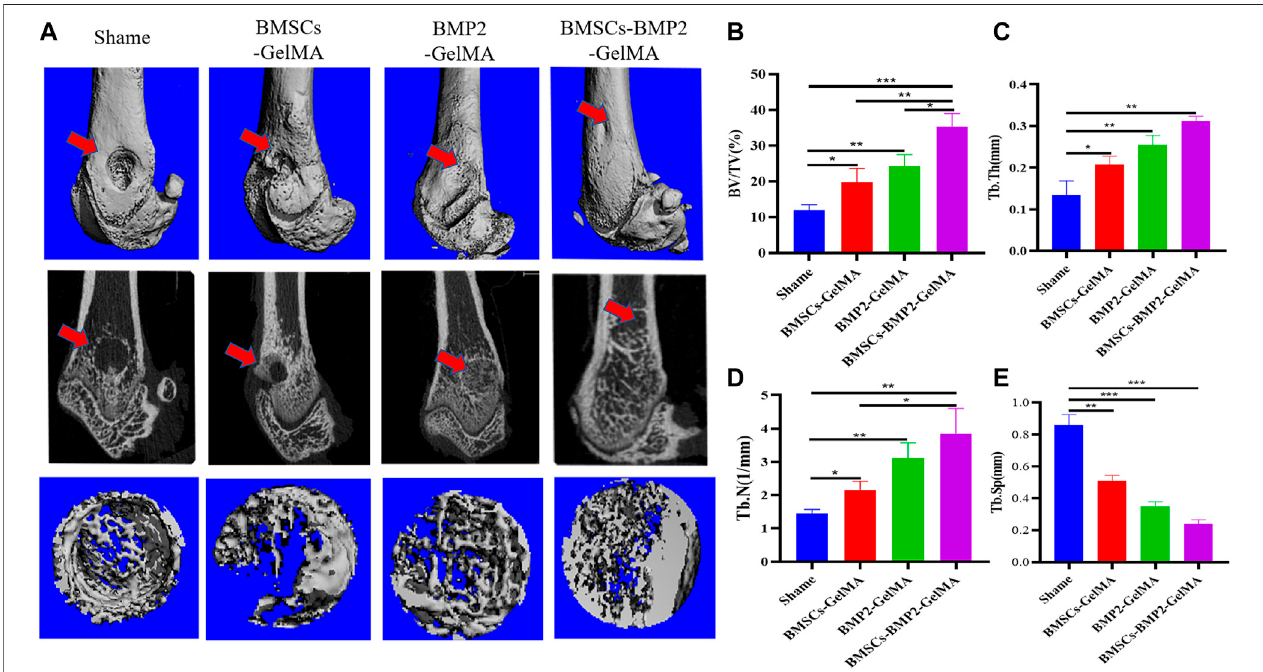
FIGURE6| Invivo osteogeniceffectsofthebioactivescaffolds.Reconstructionof3Dmicro-CTimages (A) .Quantitativeanalysisofmicro-CTimagesafter8 weeks of respective scaffolds implantation, including BV/TV (B) , Tb.Th (C) , Tb.N (D) , and Tb.Sp (E) .